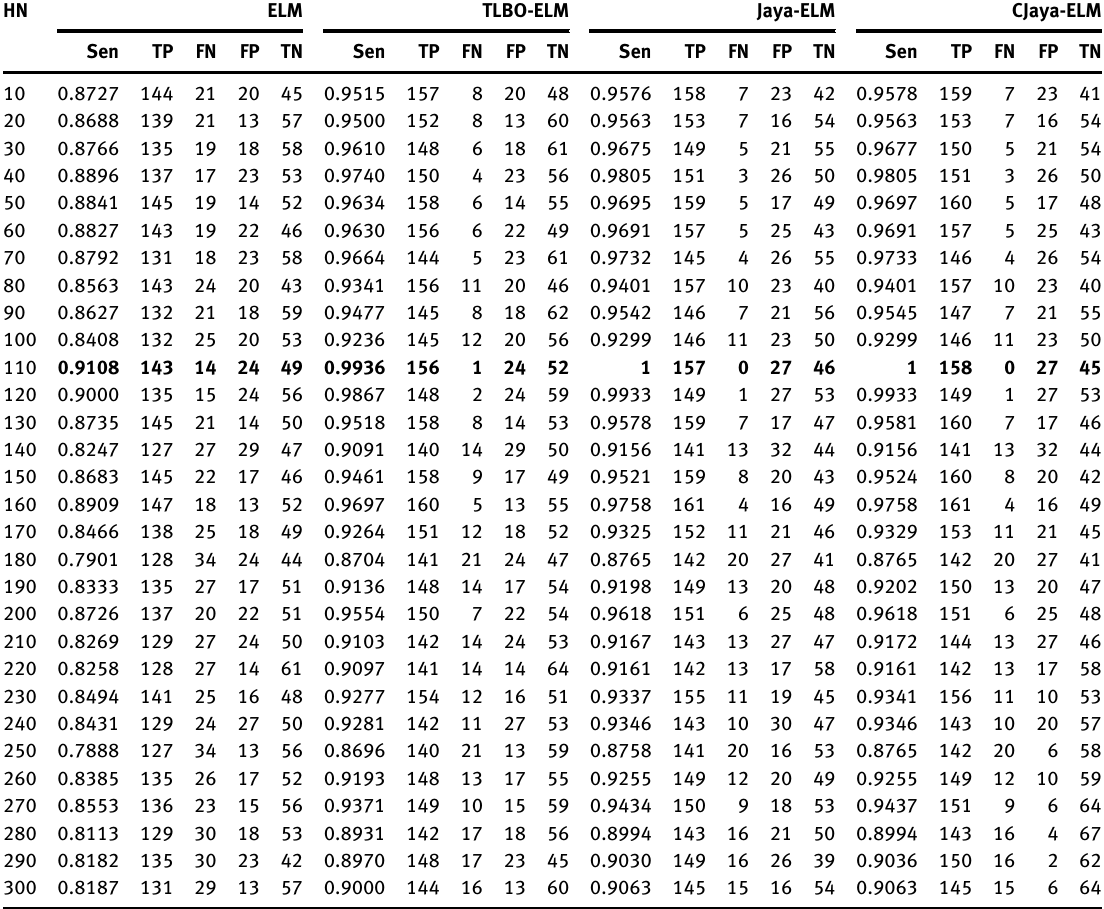
Table  : Sensitivity, TP, FN, FP and TN values for ELM, TLBO-ELM, Jaya-ELM and CJaya-ELM.